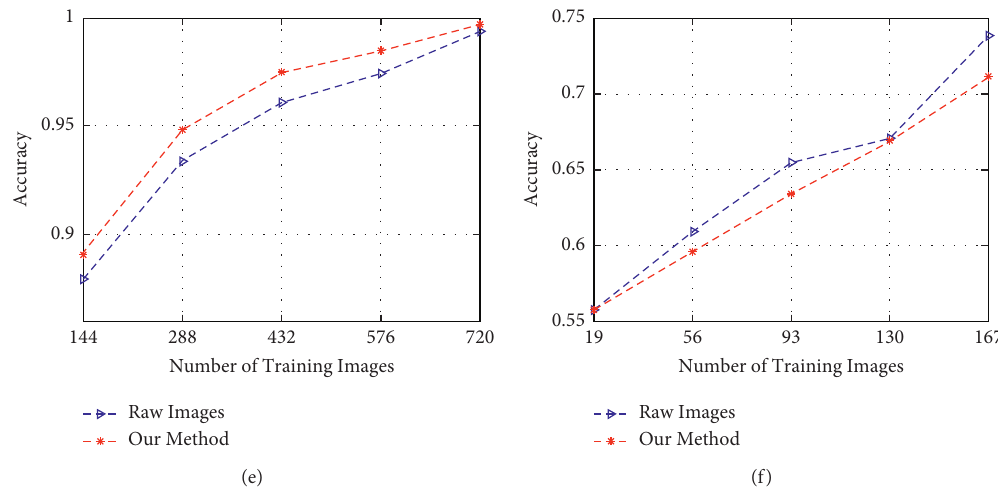
Figure 2: Accuracy vs number of training images on (a) ORL, (b) YALE, (c) UMIST, (d) MNIST, (e) COIL20, and (f) LEAVES data sets.